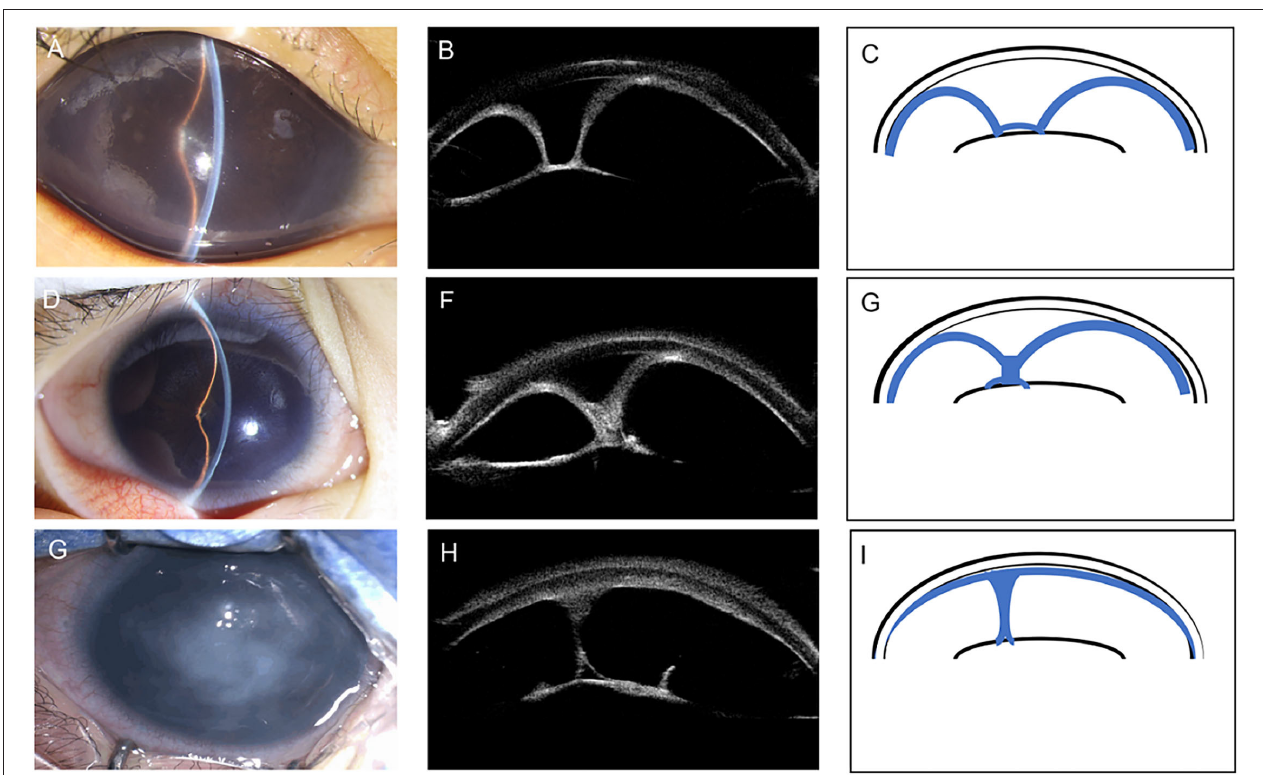
FIGURE 1 | Anterior segment photography, corresponding ultrasound biomicroscopy (UBM) images, and schematic illustrations demonstrating the three different types of congenital fibrovascular pupillary membrane-induced secondary glaucoma (CFPMSG). (A–C) Type I CFPMSG: “U”-shape configuration of iris, with complete pupillary obstruction with a fibrovascular membrane and iris bombé with peripheral anterior synechiae, but some central anterior chamber depth. (D–F) Type II CFPMSG: “Y”-shape configuration of iris with more severe iris bombé and peripheral anterior synechiae and central iris adhesion to the fibrotic membrane. (G–I) Type III CFPMSG: absent anterior chamber depth detectable, manifested as complete iris-cornea